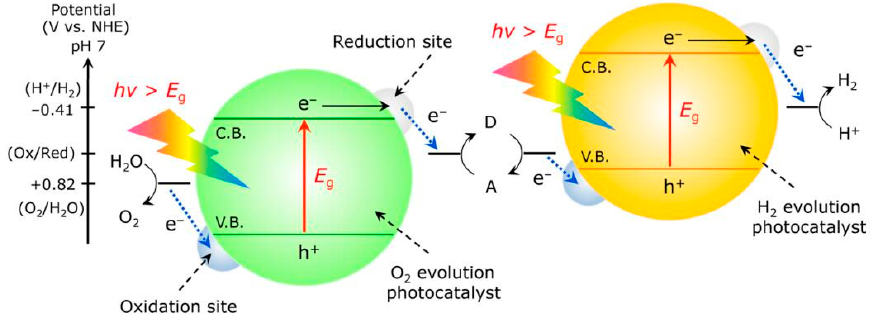
Figure 9. Diagram of photocatalytic water splitting using a Z-Scheme system. Reproduced with permission from Reference [98]; Copyright (2010), American Chemical Society.